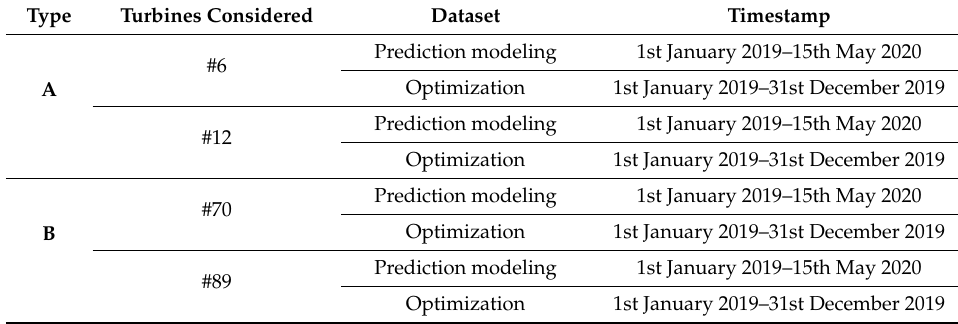
Table 2. Description of prediction modeling and optimization datasets.